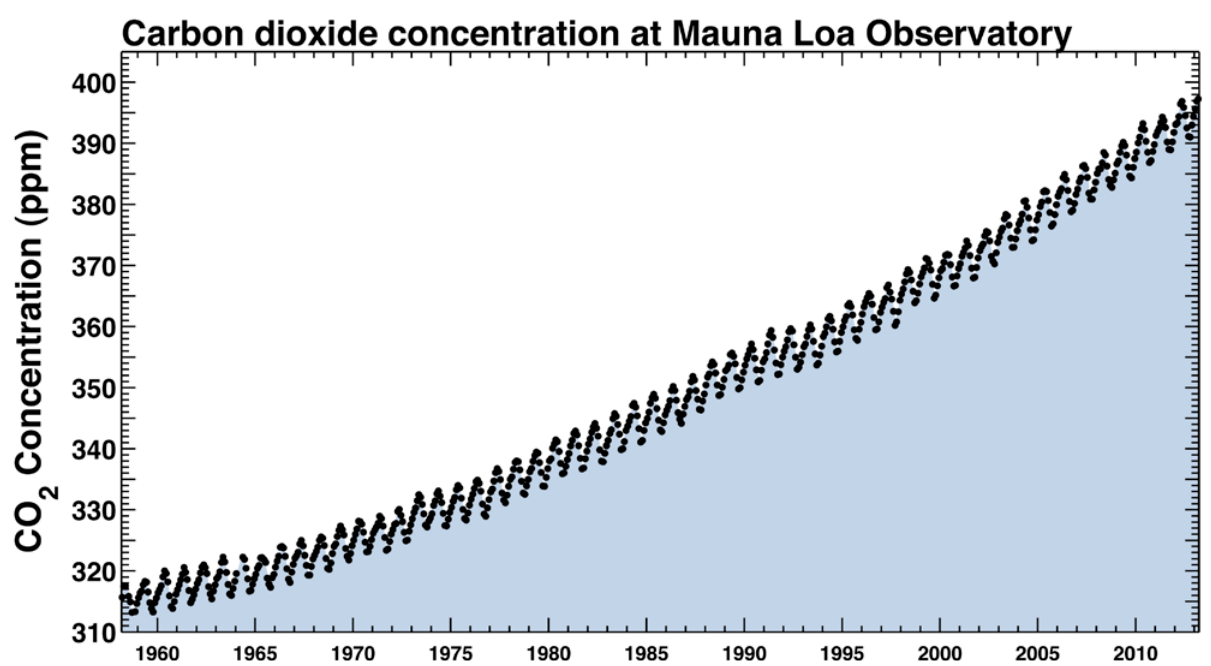
Figure 6. The Keeling Curve through 2019. Courtesy Ralph Keeling, Scripps Institute of